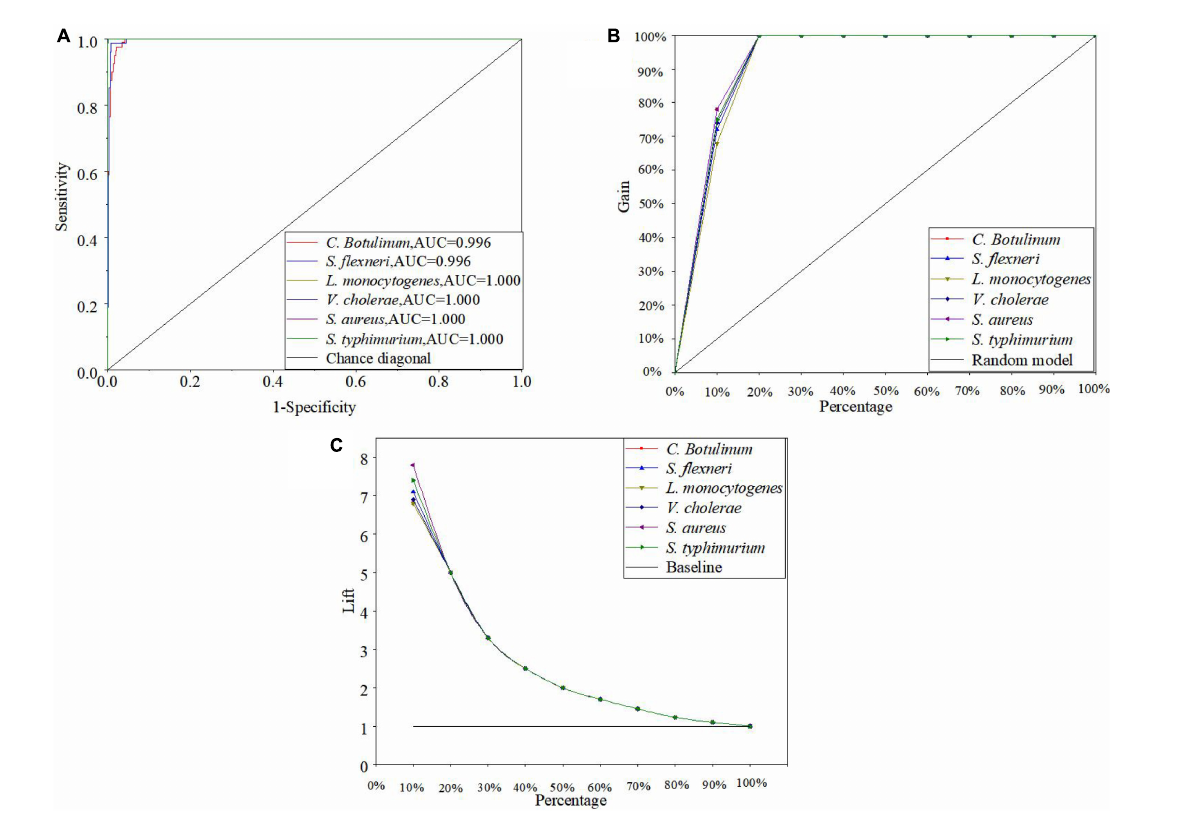
FIGURE6 ROC curve (A) , cumulative gains (B) , and lift charts (C) of the optimal ANN model in this study.